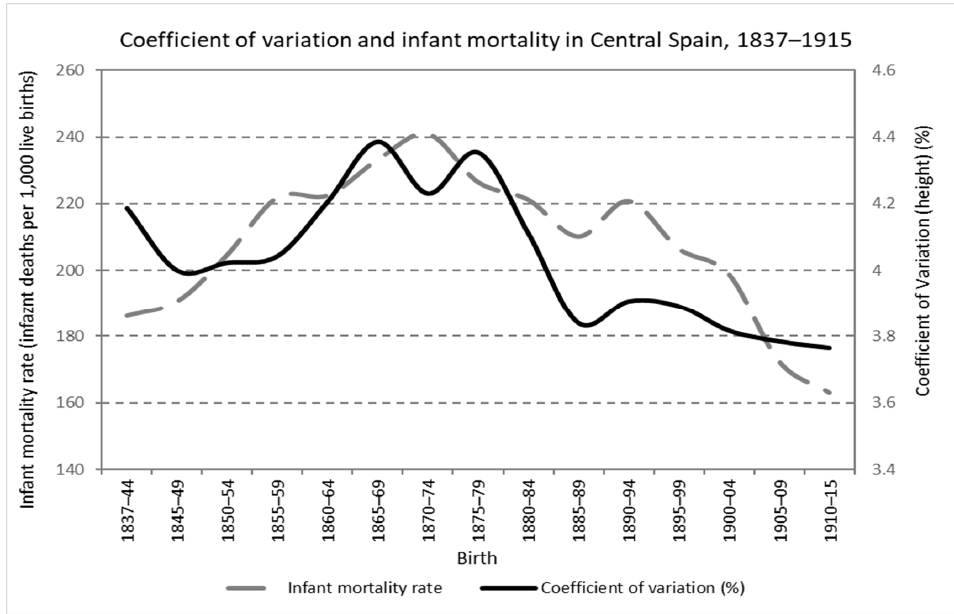
Figure 8. Coefficient of variation and infant mortality in central Spain, birth cohorts 1837–1915 (Source: calculated with data from the Expedientes and [52]).